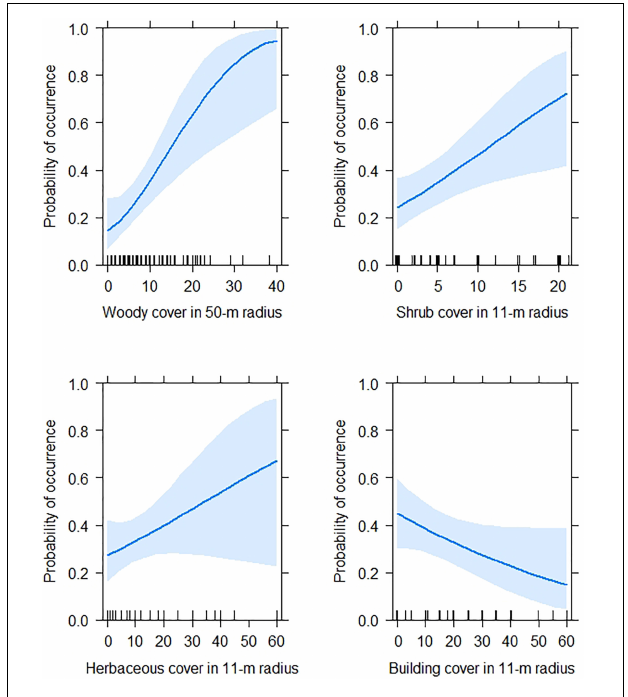
FIGURE 3 | Results from Generalized Linear Models predicting the occurrence the Green-backed Firecrown hummingbird according to habitat variables.